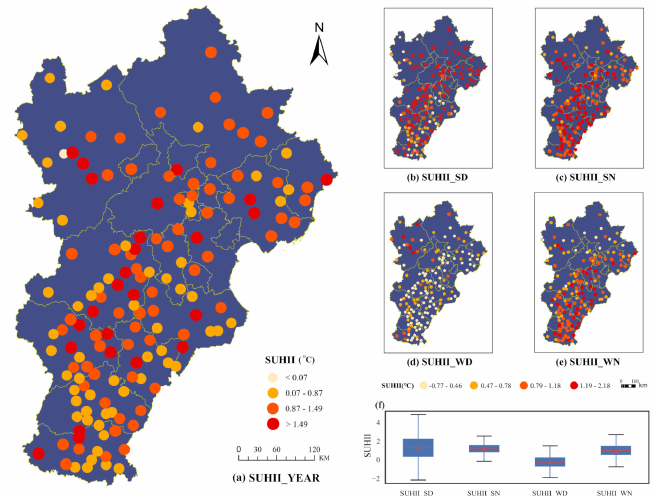
Figure 4. The spatial distribution of SUHIIs. (The spatial distribution of the SUHII_YEAR ( a ), summer days (SD) ( b ), summer nights (SN) ( c ), winter days (WD) ( d ), and winter nights (WN) ( e ). ( f ) is the SUHII box plot during all